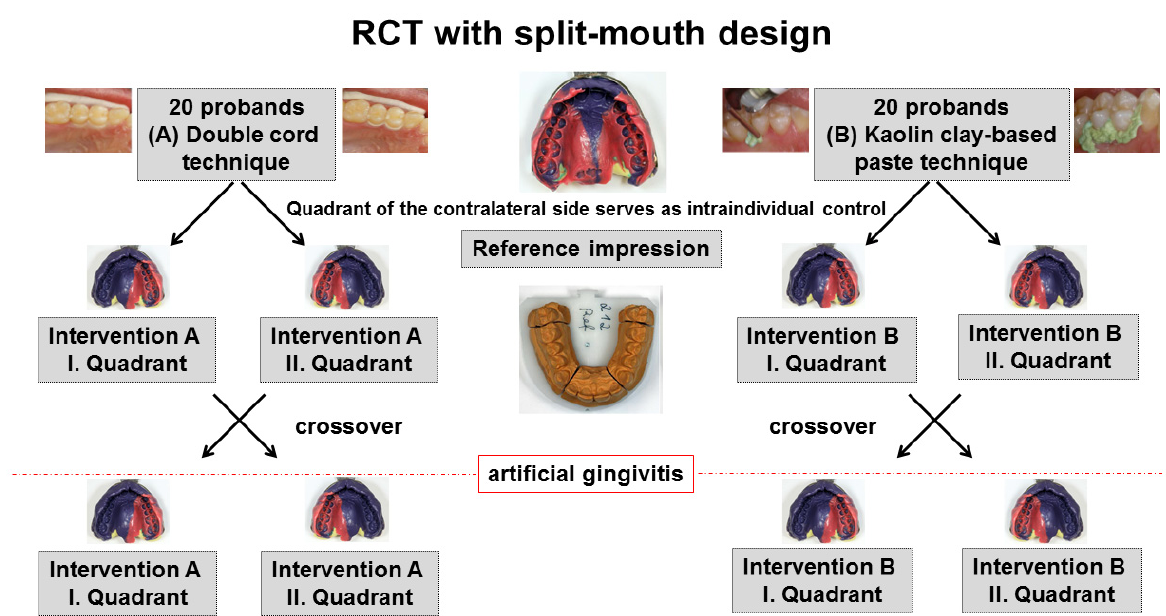
Figure 1. Study design of the randomized clinical trial (RCT) with split-mouth design with the two interventions ( A ) double cord technique or ( B ) kaolin clay-based paste for gingival displacement prior to conventional impression making.